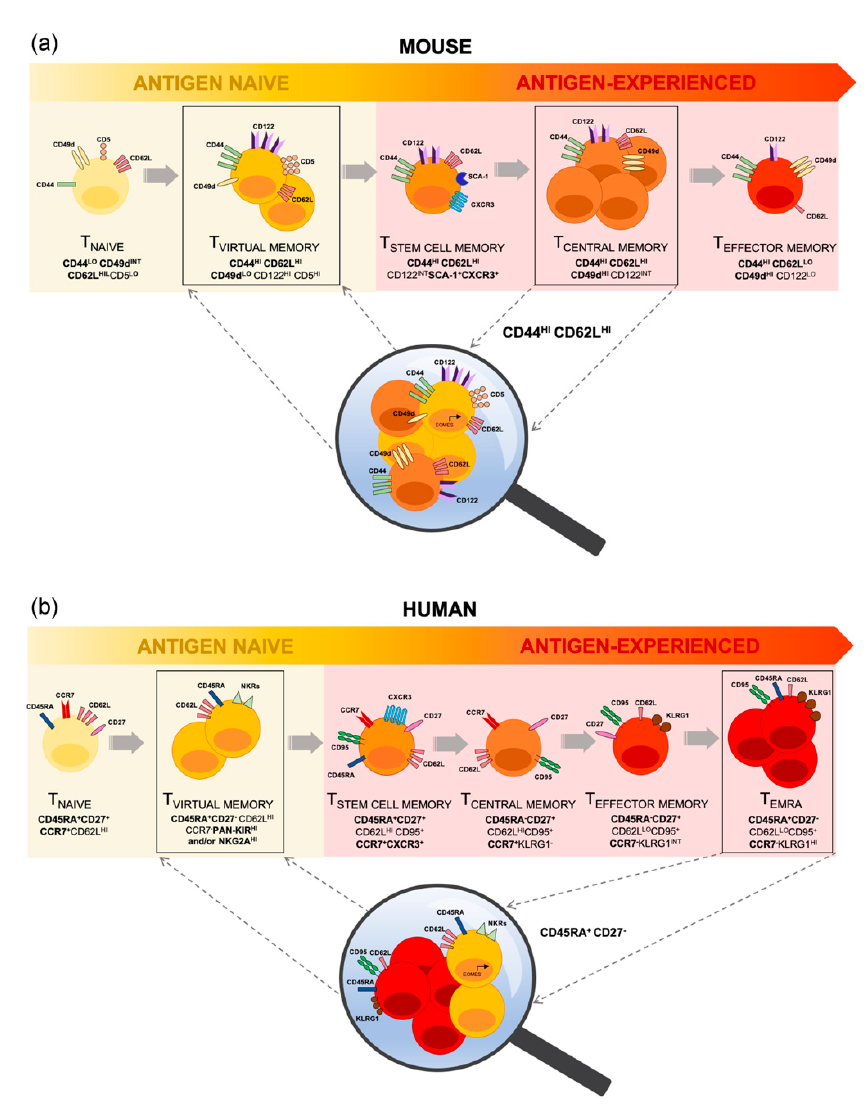
Figure 1. The Di ff erentiation Continuum and Defining Phenotype of Steady-State CD8 + T cells. CD8 +